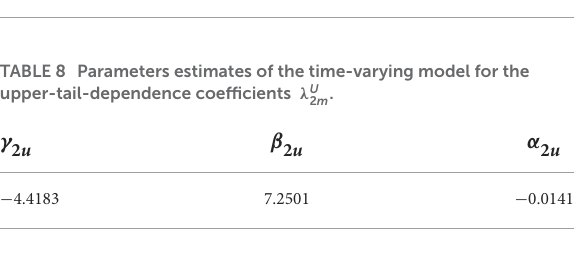
TABLE 9 RMSE values of estimated values and sample